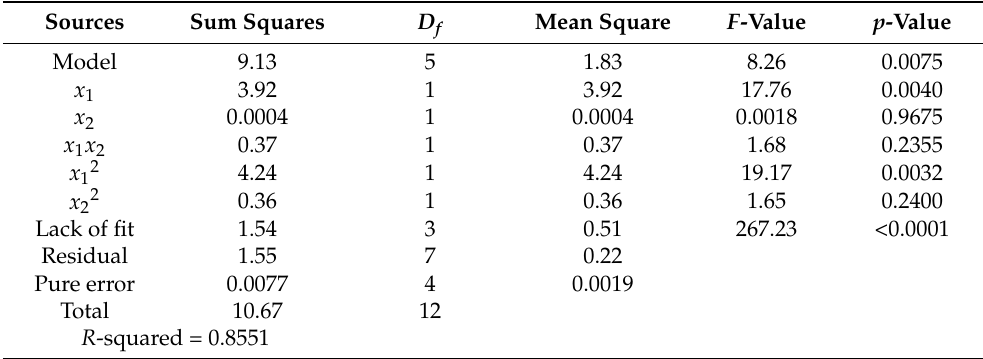
Table 10. The analysis of variance (ANOVA) for the parameters of the RSM based on a CCD fitted to a quadratic response surface